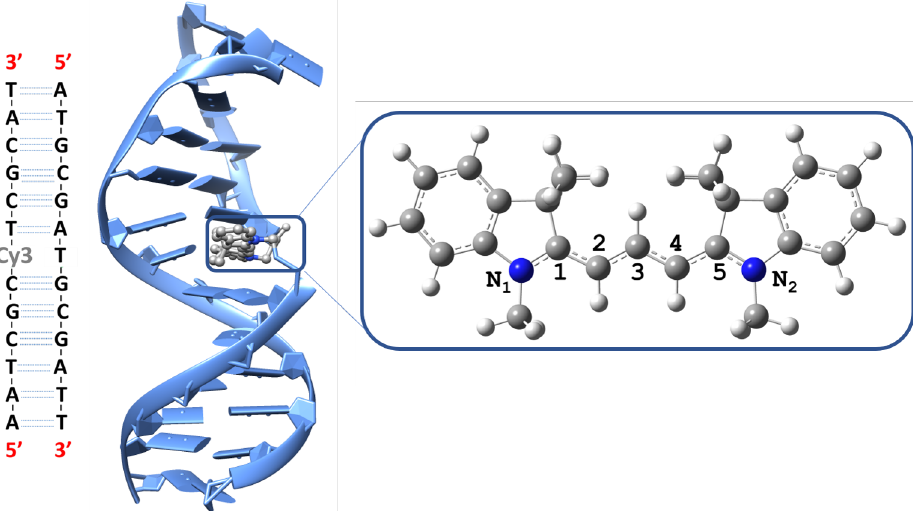
Figure 1. Left : The Cy3-DNA sequence studied [5]. Middle : Snapshot from the molecular dynam- ics equilibrated structure. Right : Cy3 ground state structure optimized using ω B97XD/Def2SVP showing the polymethine chain atoms numbered from 1 to